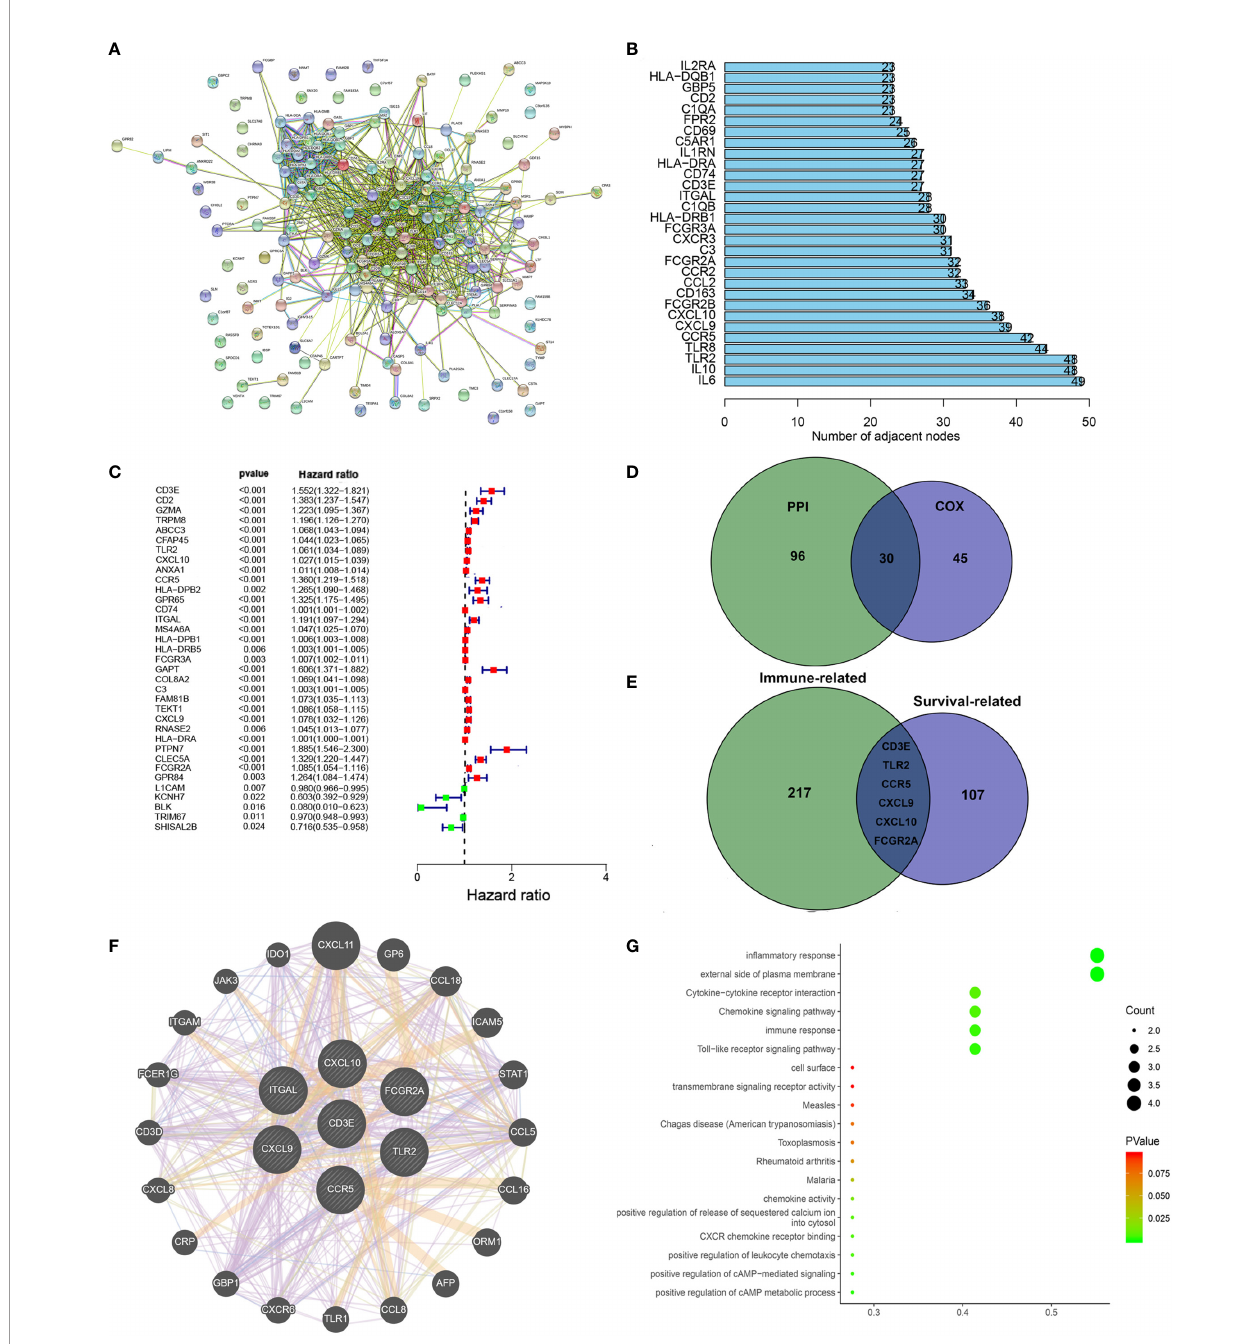
FIGURE 6 | Protein – protein interaction network and univariate COX. (A) Interaction network constructed with String. (B) The top 30 genes ordered by the number of nodes. (C) Univariate COX regression analysis with DEGs was done, listing the top signi fi cant factors with P < 0.001. (D) Venn plot showing the common factors shared by nodes in PPI and top signi fi cant factors in univariate COX. (E) Venn plot showing the common factors shared by nodes in Stromal related DEGs and Clinical-related DEGs. (F) Interaction network constructed with 7 genes. (G) GO and KEGG pathway analyses on 7